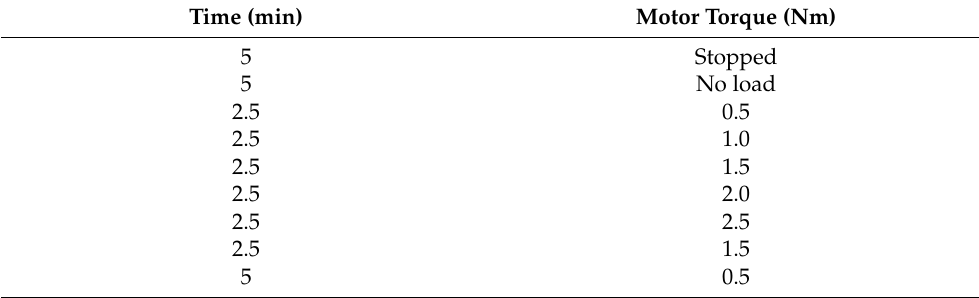
Table 11. Test values.